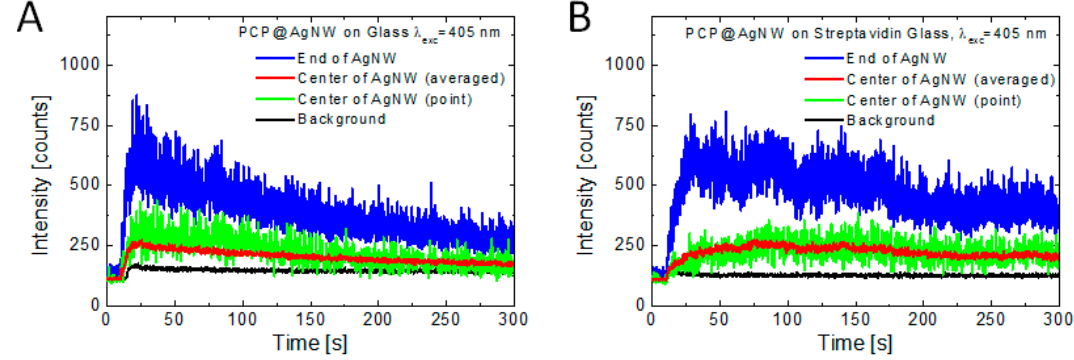
Figure 4. Time-traces of fluorescence intensity measured at the ends (blue lines) and along the AgNWs (red and green lines for averaged and non-averaged data, respectively), as well as background signal level (black lines) measured for the bare glass ( A ) and streptavidin-functionalized glass ( B ) substrates.